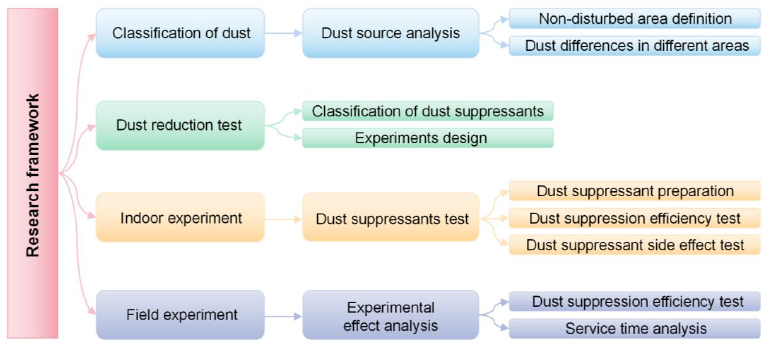
Figure 1. Research